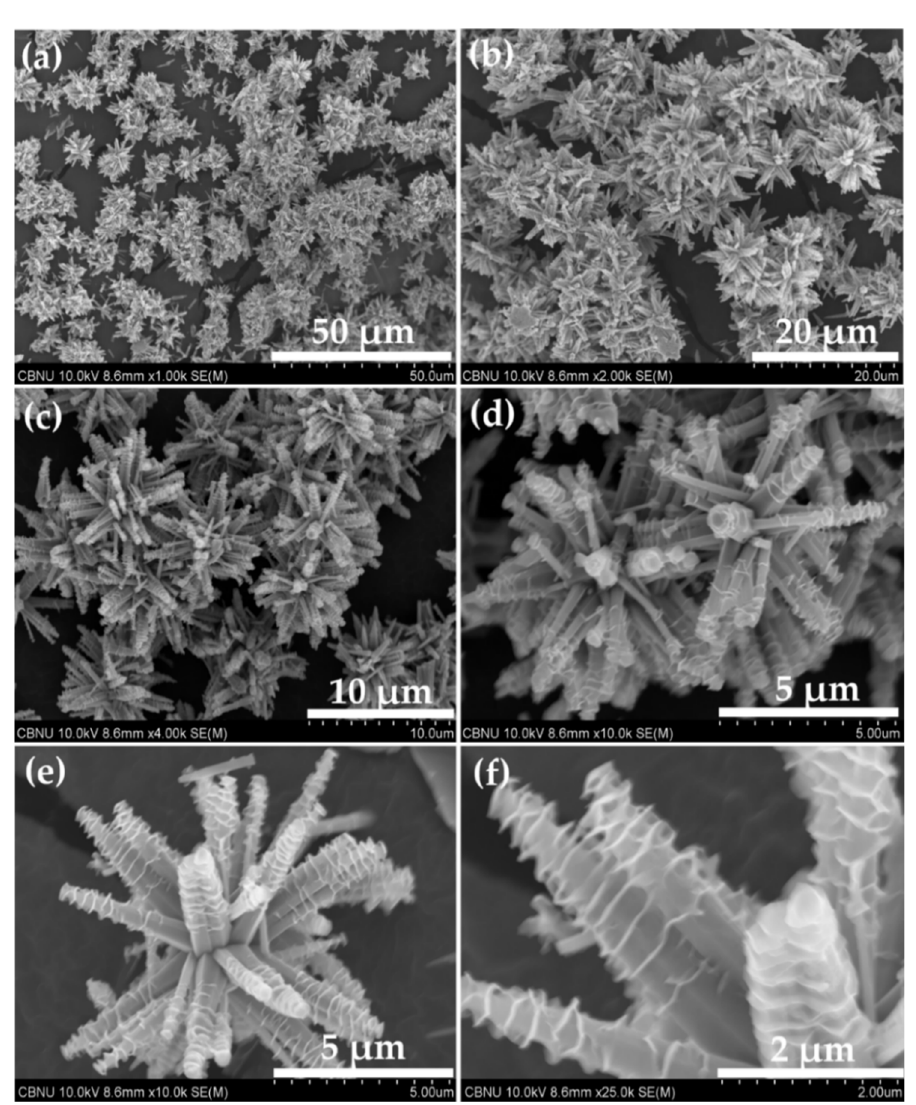
Figure 2. FESEM micrographs of synthesized Ag-doped ZnO nanoflowers decorated with